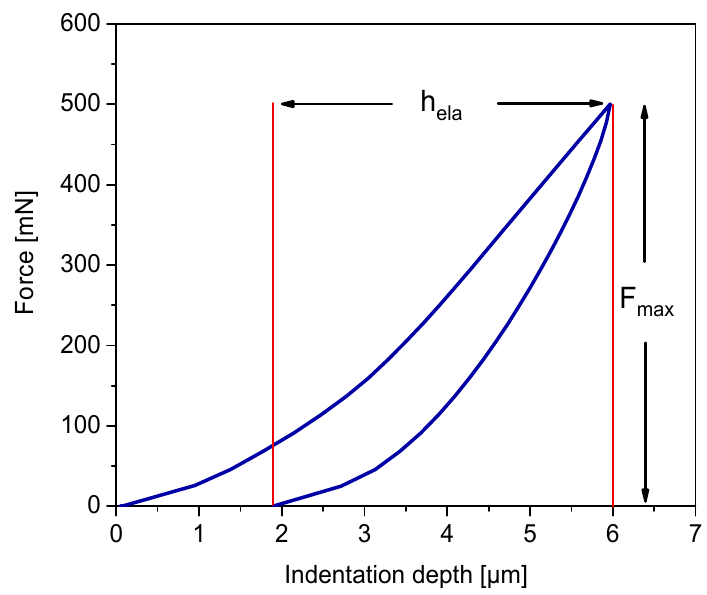
Figure 3. Example of force–displacement curve on a tablet. Material: Pharmacel ® 102. Compaction pressure: 175 MPa. Max. indentation force: 500 mN.